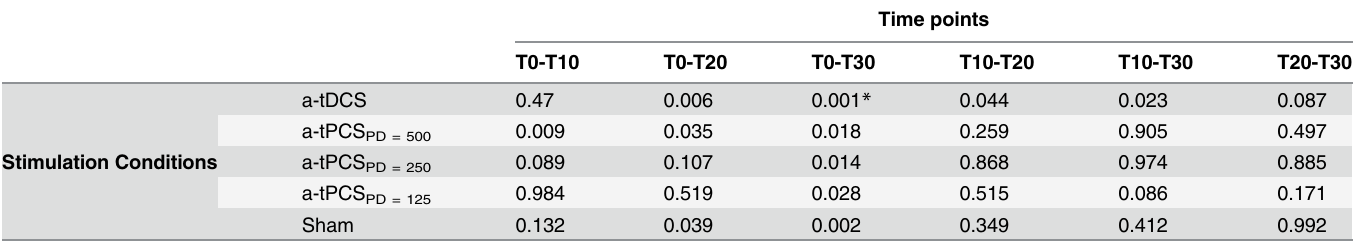
Table 5. Significant differences between repeated post stimulation readings of MEP amplitudes within each condition. The results were considered significant at the level of P (cid:3)